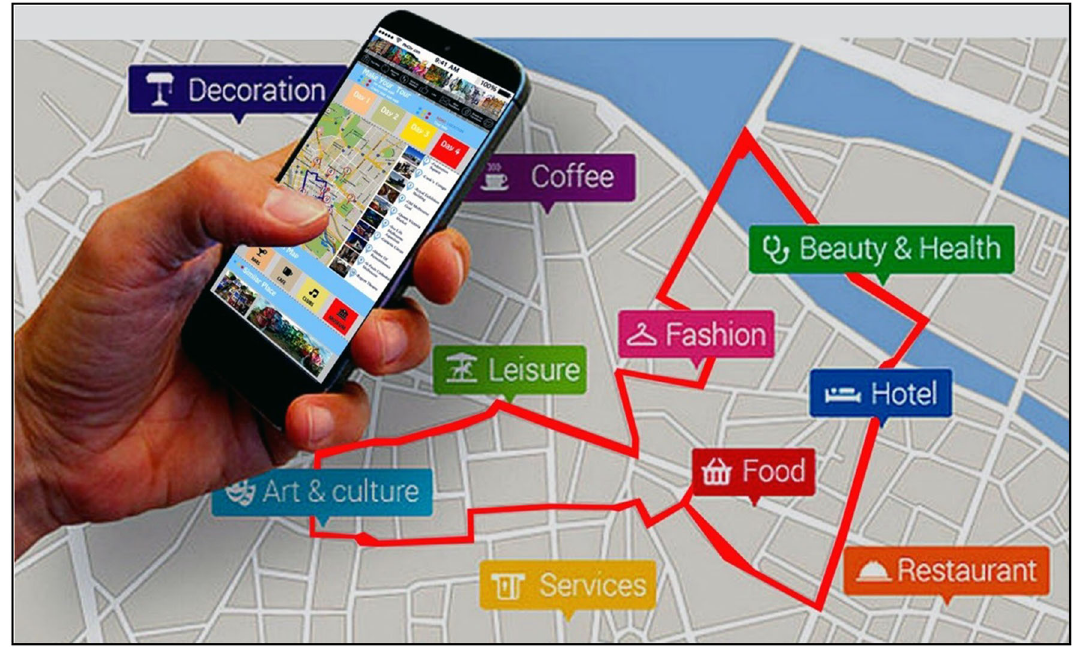
Fig. 1 Tourism industry and ICT (Internet, mobile